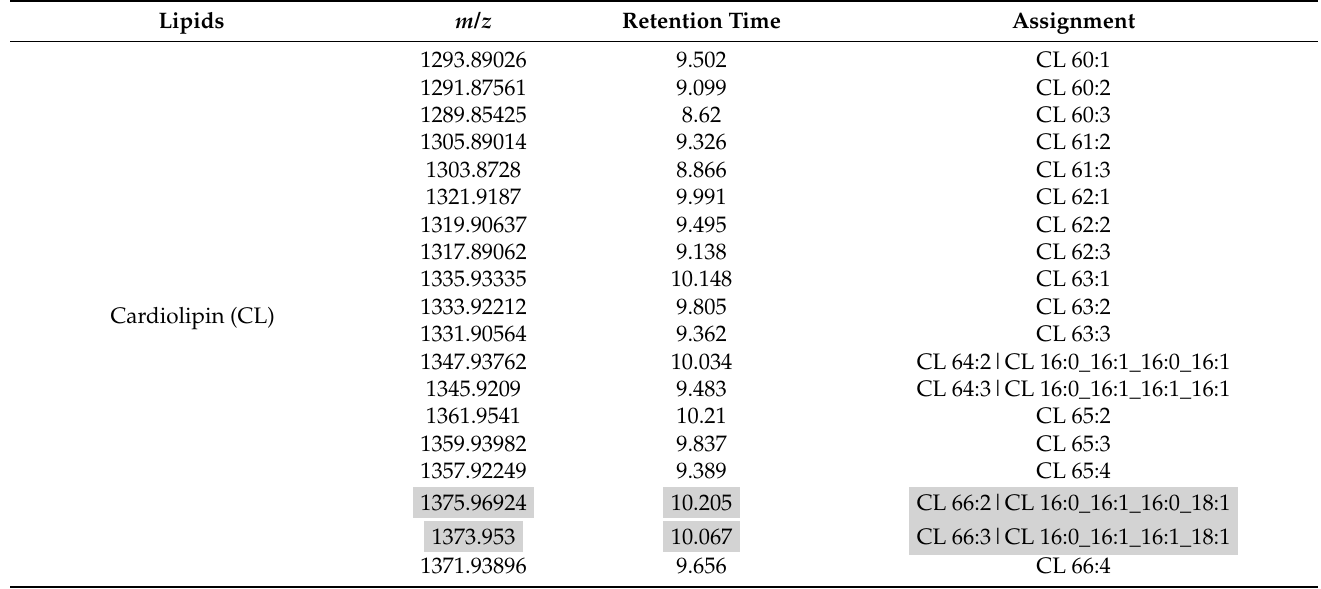
Table 2. Lipid assignments of the total lipid extract of Acinetobacter baumannii 721164 grown in LB and analyzed by LC-HRMS 2 . The adduct type for Cardiolipin (CL), Monolysocardiolipin (MLCL), Hemibismonoacylglycerophosphate (HBMP), Lysophosphatidylethanolamine (LPE), Phosphoethanolamine (PE), and Phosphatidylglycerol (PG) is [M-H]-; for Phosphatidylcholine (PC) is [M+H]+; for Diacylglycerol (DAG) and Triacylglycerol (TAG) is [M+NH4]+. Lipids in grey are found in quantities over 5% of the total lipid sub-classes with CL/MLCL, PE/LPE, and DAG/TAG gathered to calculate the percentage of each lipid species. The highest abundant lipid species are in